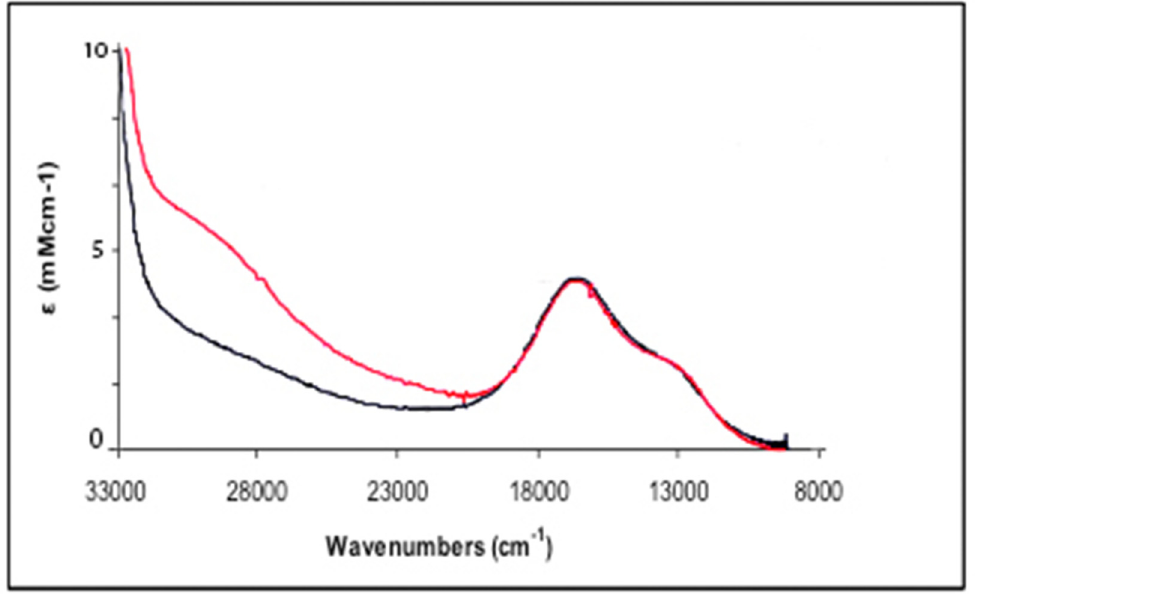
Fig 4. UV-visible absorption spectra of the AR form of Mv BOD (black) and the reoxidized form (red).